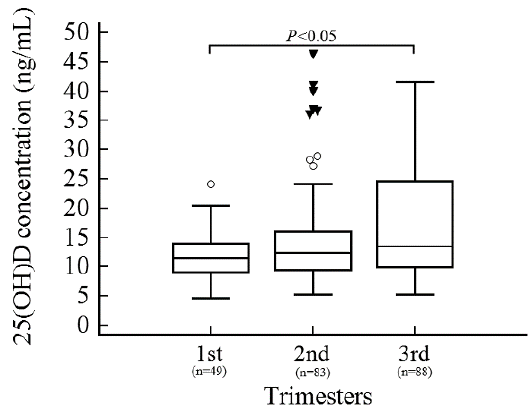
Figure 1. Serum 25-hydroxyvitamin D—25(OH)D—concentration according to trimester.